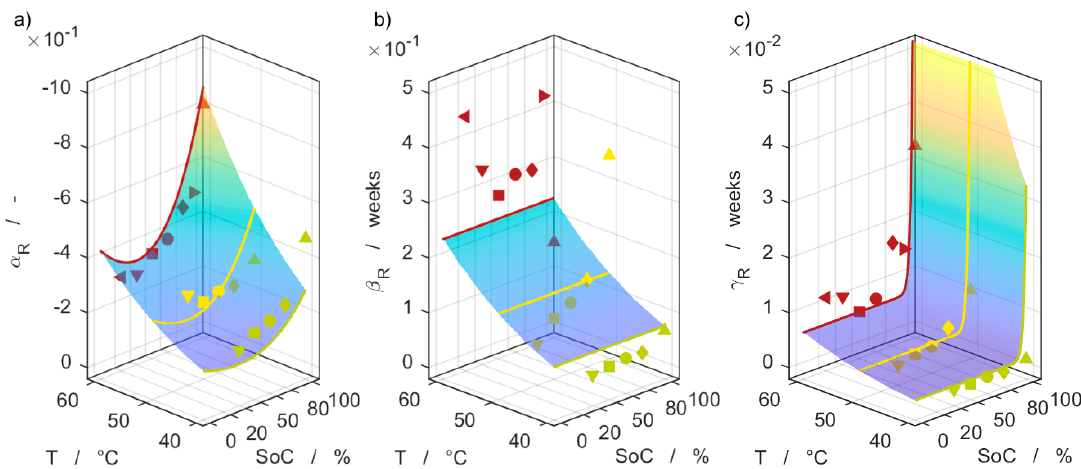
Figure 9. Comparison of the fit coefficients obtained from the R ohm aging 2D and 4D fits. The markers indicate the results of the individual 2D fits with constant ( a ) α R , ( b ) β R , and ( c ) γ R . The colored lines represent the characteristic SoC dependency of the overall 4D fit evaluated at the three temperatures. The color shaded plane shows the SoC and Arrhenius temperature dependency of the 4D fit and the markers are same as in Figure 7.